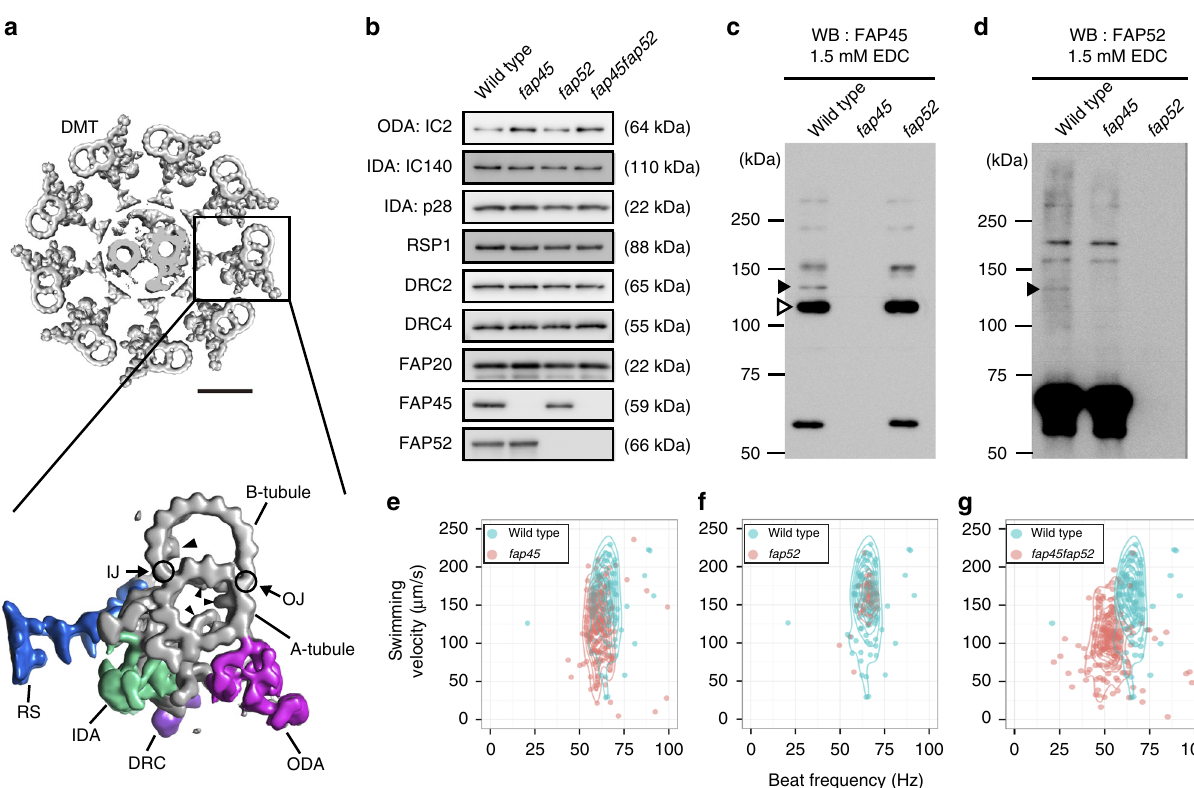
Fig. 1 Characteristics of the FAP45 and FAP52 null mutants. a Top: a transverse view of the 9 + 2 structure of the Chlamydomonas axoneme. Scale bar = 50 nm. Bottom: a magni fi ed DMT. Arrowheads indicate MIPs. Major structures are colored; Outer dynein arm (ODA, magenta); Inner dynein arm (IDA, green); Dynein regulatory complex (DRC, purple); Radial spoke (RS, blue). IJ inner junction, OJ outer junction. Scale bar = 25 nm. b Western blot analyses of wild type, fap45 , fap52 , and fap45fap52 double mutant axonemes stained with various antibodies. FAP45 and FAP52 proteins were not detected in fap45 and fap52 , respectively. Proteins essential for fl agellar motility (ODA-IC2: outer dynein arm-intermediate chain 2; IDA-IC140: inner dynein arm- intermediate chain 140; IDA-p28: inner dynein arm-light chain p28; RSP1: radial spoke protein 1; DRC2 and 4: dynein regulatory complex 2 and 4; FAP20: inner junction protein of DMT) were not reduced in the mutants. c , d Axonemes from wild type and mutant Chlamydomonas crosslinked using EDC (zero- length crosslinker) were immunoblotted with anti-FAP45 ( c ) and anti-FAP52 antibodies ( d ). Filled arrowheads indicate the crosslinked product of